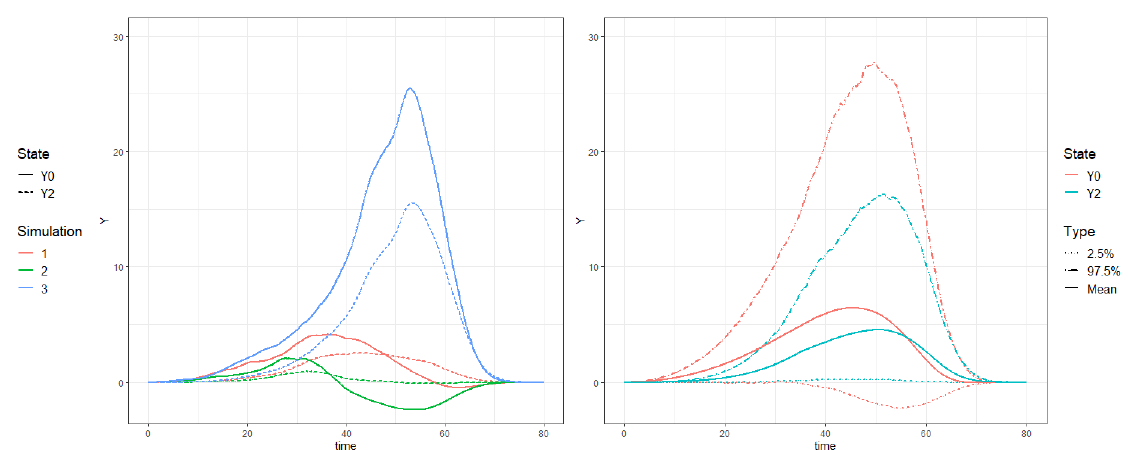
Figure 5. Left : State-wise projections of the surplus in the three simulated scenarios of the interest rate. Right : The mean and confidence intervals of the projected